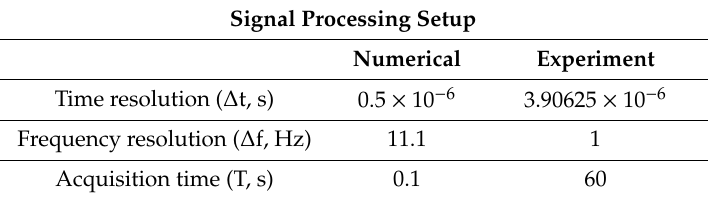
Figure 22. Time histories of ( a ) bubble radius; and ( b ) acoustic pressure due to bubbles for nuclei of initial radius 30 µm and 40 µm. Table 4. Signal processing setup for numerical and experiment